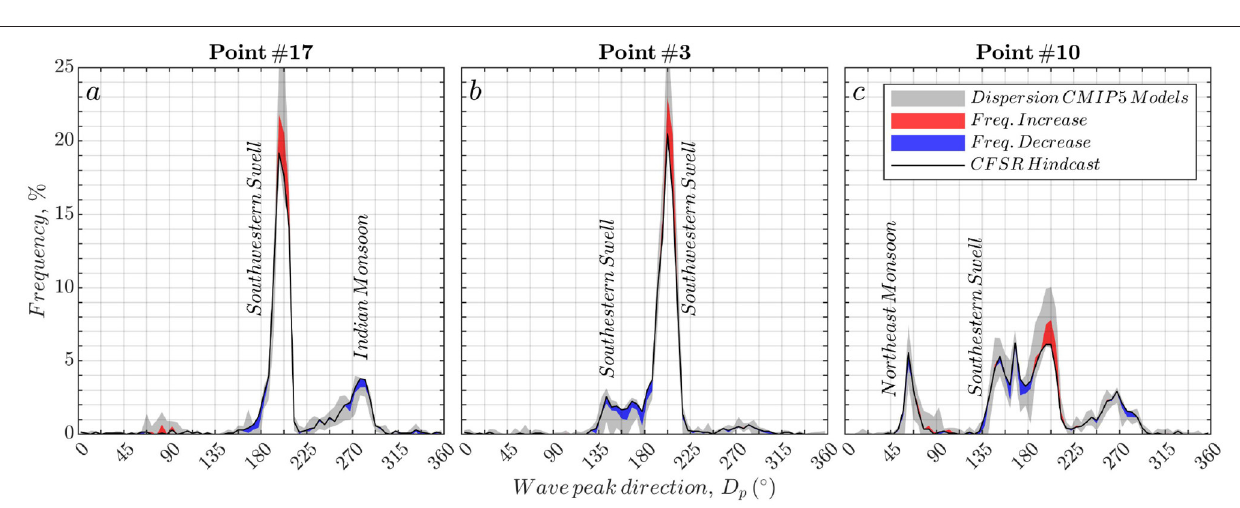
using a linear relationship between all the ( H s , T p ) events extracted at each reference point for each of the four directions of the incoming waves ( Supplementary Figure 13